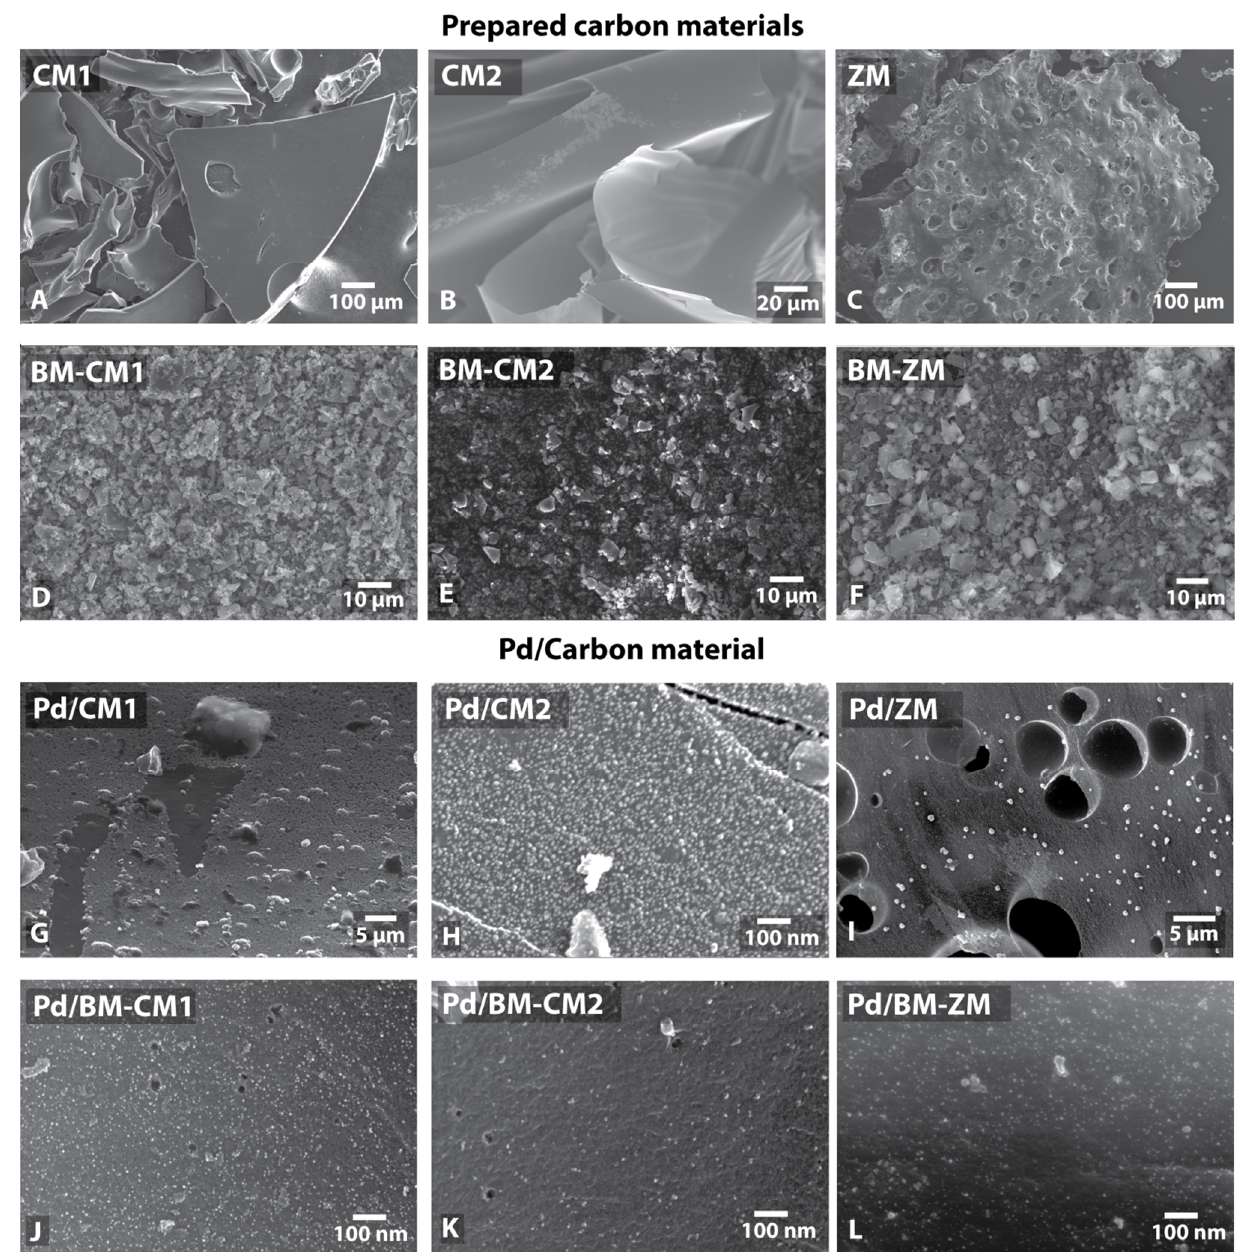
Figure 2. SEM images of prepared carbon materials ( A – C ), carbon materials after ball milling ( D – F ) and supported Pd NPs on corresponding carbon materials ( G – L